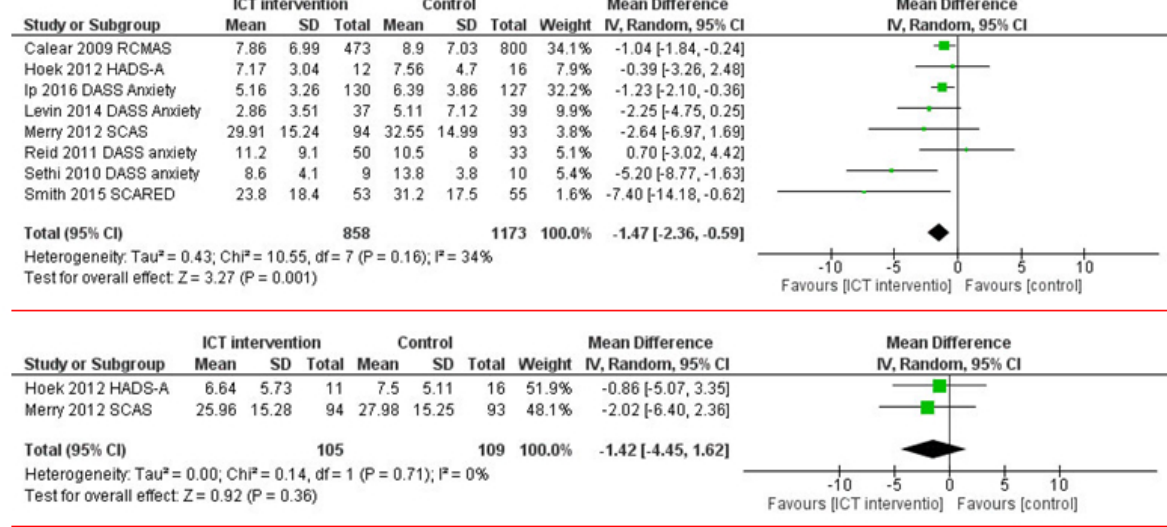
Figure 4. Short-term and mid-term effectiveness of Web-based interventions on anxiety symptoms compared with that of a control